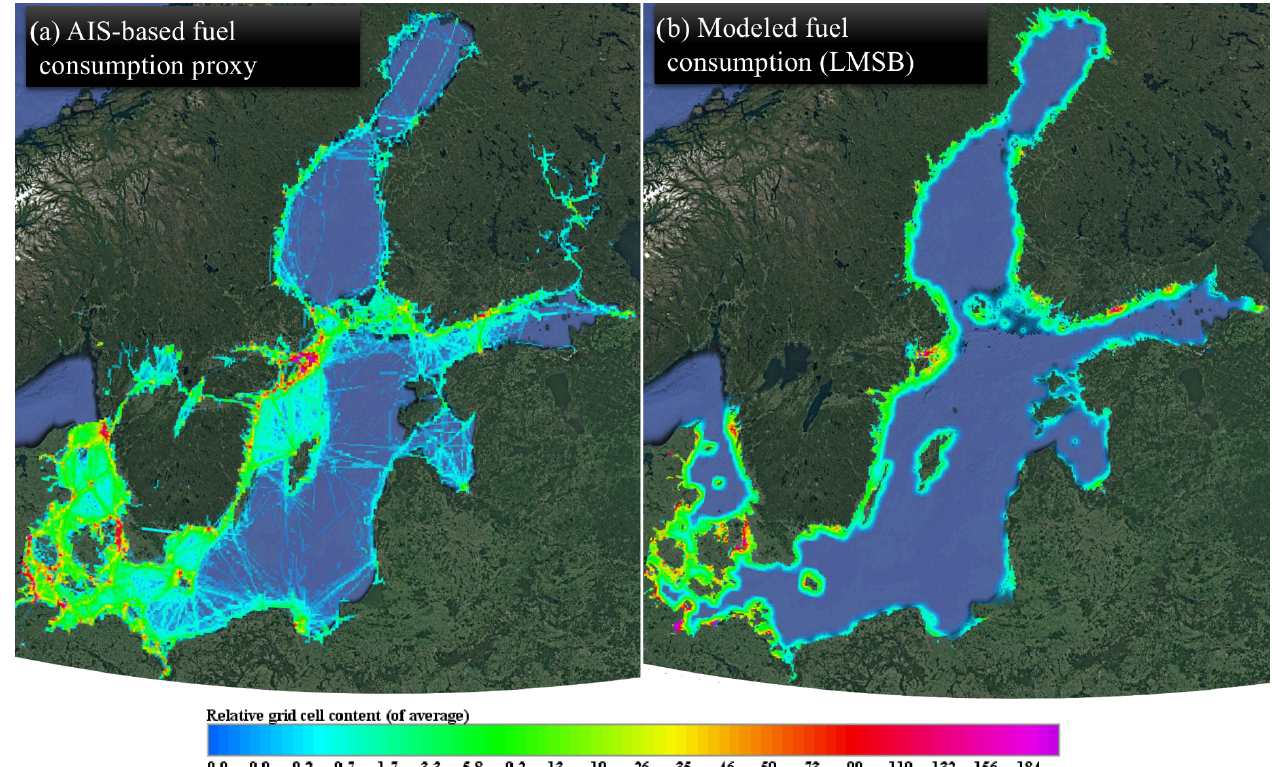
Figure 9. Estimated distribution of leisure boat fuel consumption in terms of grid cell average. In (a) the predictions based on AIS (STEAM) are shown. In (b) BEAM predictions for LMSB fuel consumption is shown. Satellite image background provided by © Google Earth.